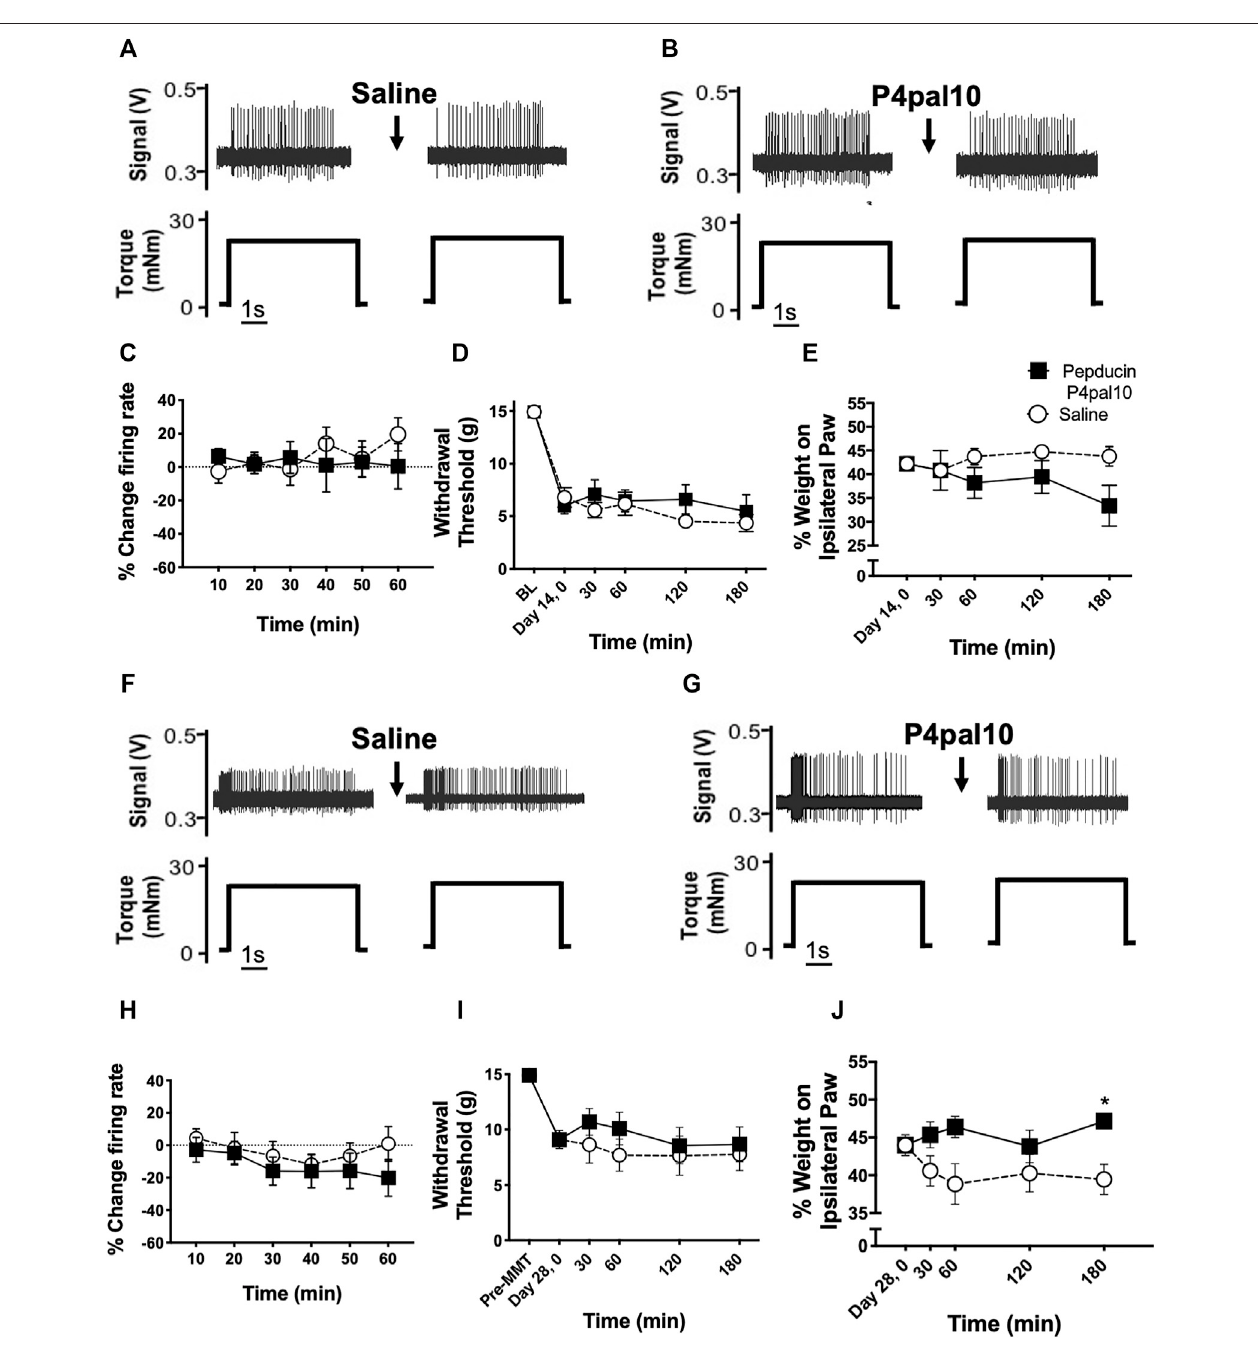
FIGURE 6 | Effect of PAR4 blockade on Endstage OA/PTOA Pain Behaviour and Joint Electrophysiology. Representative traces of knee joint afferent recordings fromday14MIAanimals (A – B) andday28MMTanimals (F – G) beforeandafteradministrationofsalineorpepducinp4pal10.BlockadeofPAR4withpepducinP4pal10 failed to reduce joint afferent fi ring in day 14 MIA animals (C) or day 28 MMT animals (H) compared to saline vehicle ( p > 0.05, 2-way RM-ANOVA, n (cid:1) 7 – 11). Administration of pepducin P4pal10did not signi fi cantly improve secondary allodynia (D) or weight bearing de fi cits (E) in day 14 MIA animals ( p > 0.05, 2-way RM- ANOVA, n (cid:1) 7). When day 28 MMT animals were treated with pepducin p4pal10, it did not improve withdrawal threshold (I) ( p > 0.05, 2-way RM-ANOVA, n (cid:1) 7) but did signi fi cantlyreducehindlimb weight bearing de fi cits at 180 min (J) ( p < 0.05, 2-way RM-ANOVA, n (cid:1) 7). * p < 0.05 denotes statistical signi fi cance using post hoc Sidak ’ s Multiple Comparisons Test. Data presented as means ±